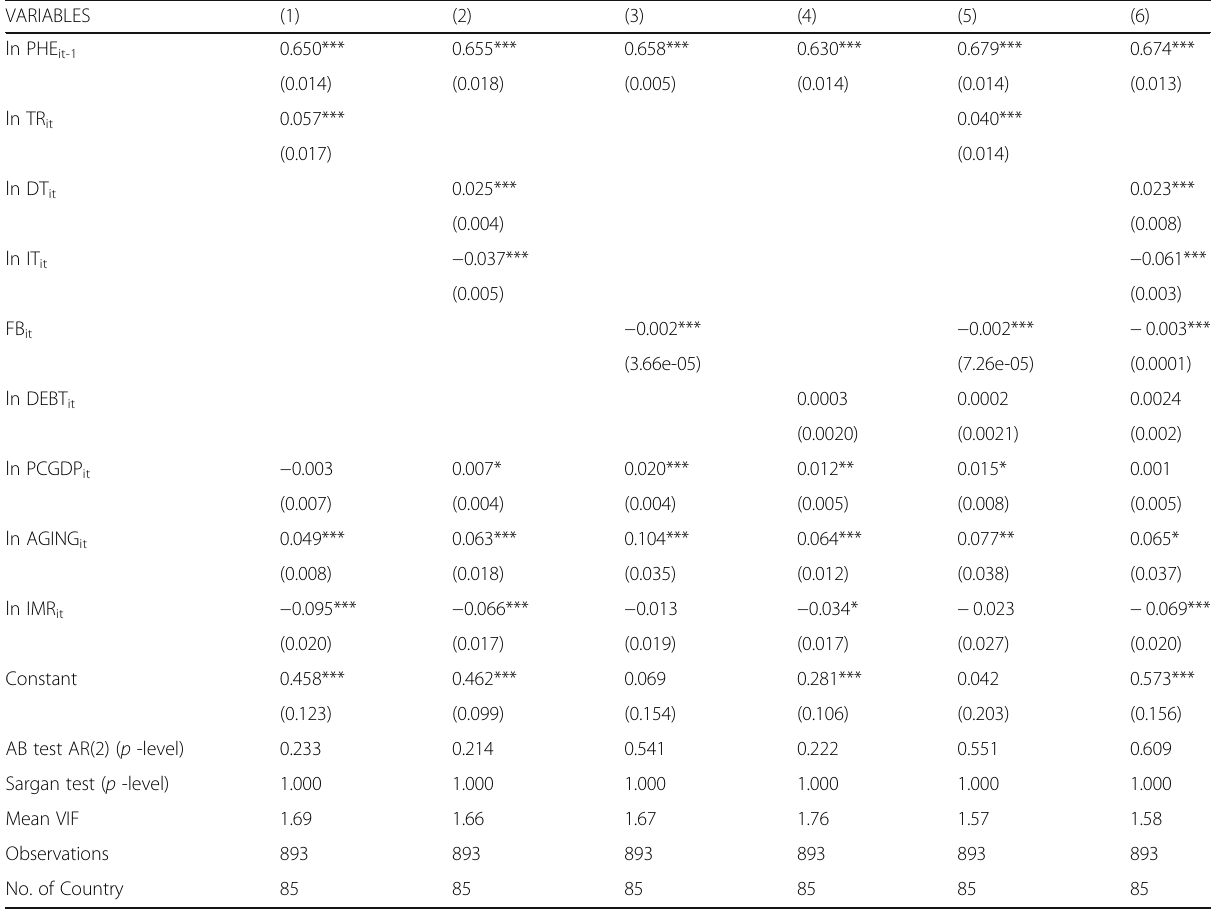
Table 1 Dynamic System GMM Regression Model (Full Sample) Dep: ln PHE it